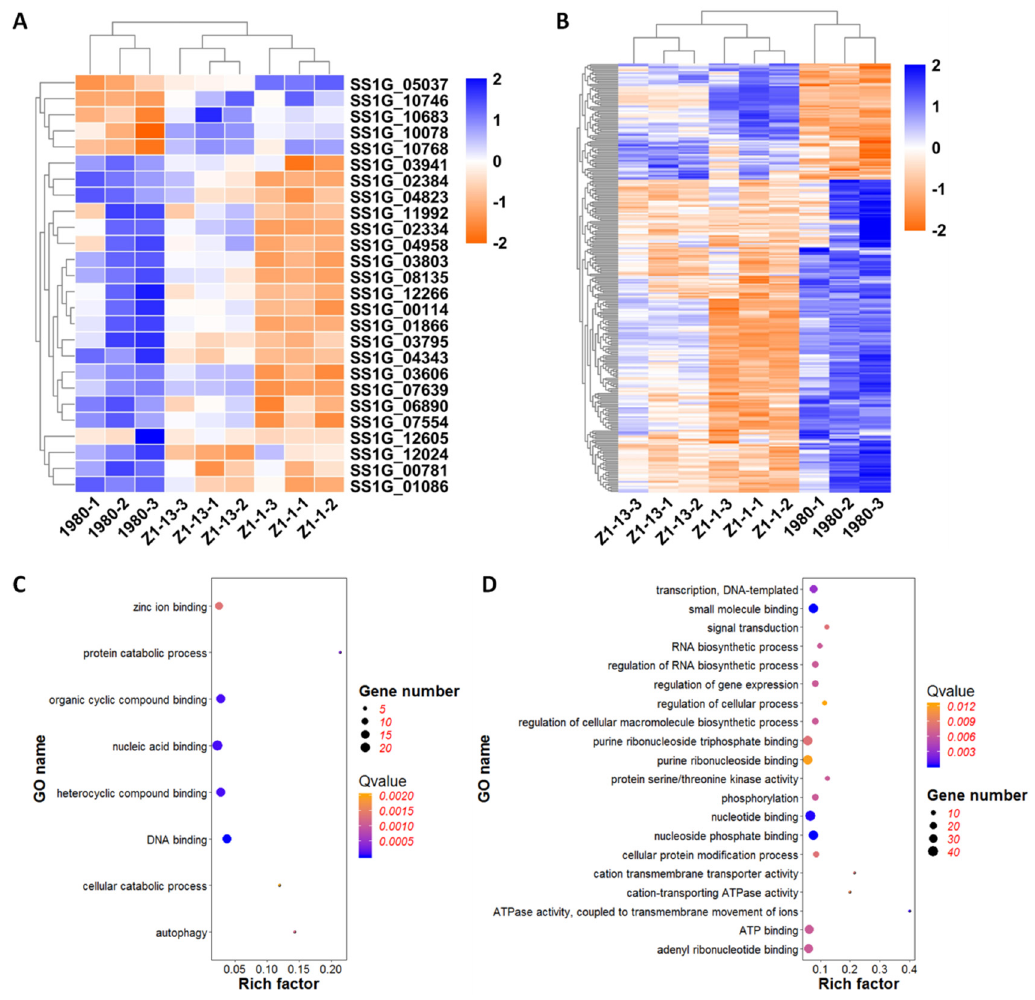
Figure 8. Heat map enrichment analysis of differentially expressed genes (DEGs) associated with secretory proteins and pathogenicity. ( A ) Heat map enrichment analysis of DEGs encoding putative secretory proteins. ( B ) Heat map enrichment analysis of DEGs related to fungal pathogenesis. ( C ) GO enrichment analysis of up-regulated DEGs associated with pathogenicity. ( D ) GO enrichment analysis of down-regulated DEGs associated with pathogenicity. The heat map displays gene names on the Y-axis and sample names on the X-axis. The color represents expression level of genes. The enrichment analysis of DEGs associated with secretory proteins and pathogenicity demonstrated that viral gene ORF I might regulate the transcription, translation, and post-translation processing through the function of DNA binding, nucleotide binding, signal transduction, and phosphorylation. At the same time, the genes involved in ATP binding and many kinase activity which affected basic functions of life activities were also enriched. 4. Discussion